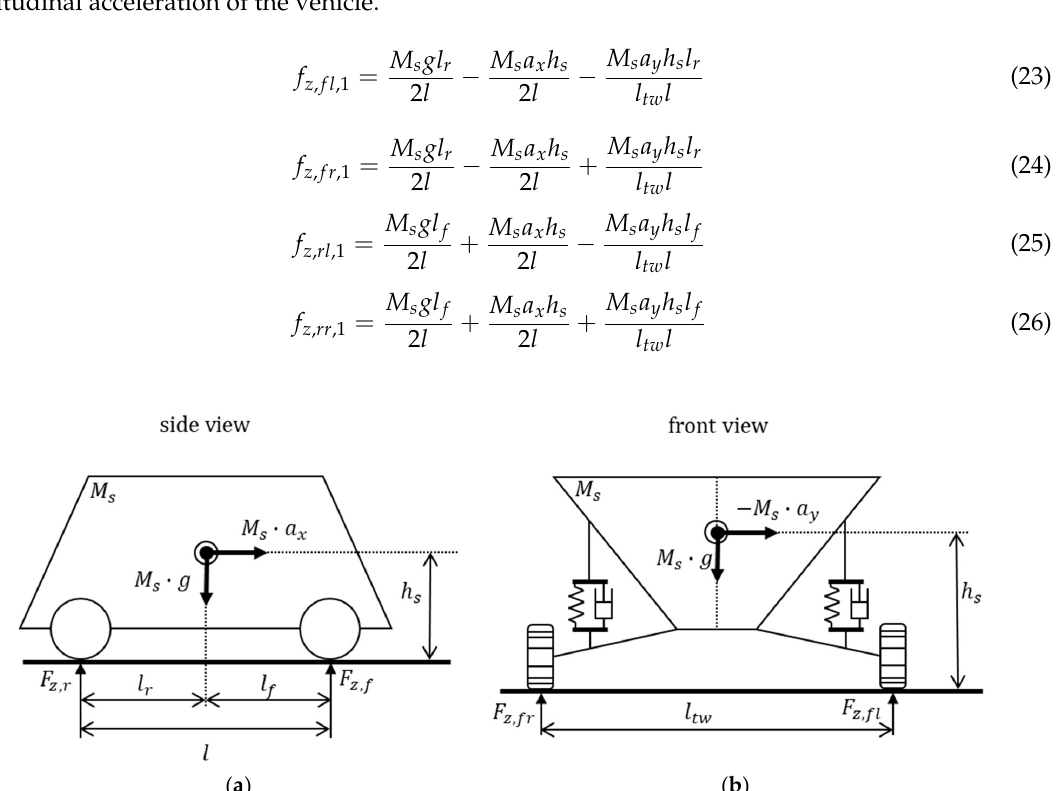
Figure 11. Vehicle normal force scheme. ( a ) Vehicle side view; ( b ) vehicle front view.